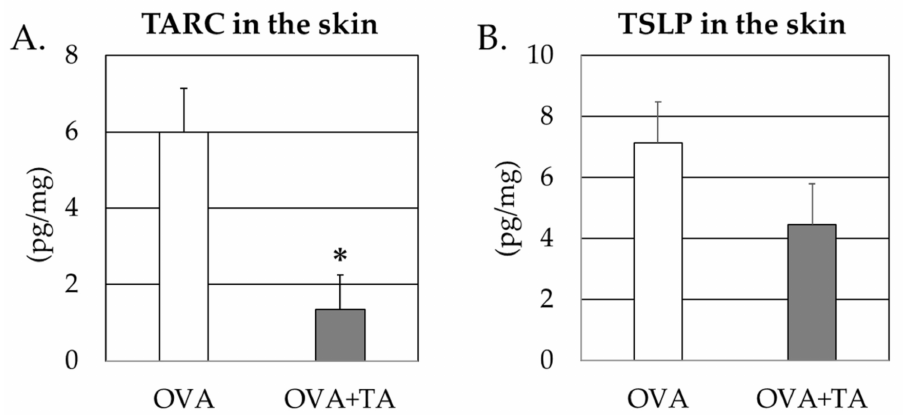
Figure 5. TSLP and TARC levels in the serum from the OVA and OVA + TA groups. ( A ) TARC levels in the serum at 3 w and 4 w. ( B ) TSLP levels in serum at 3 w and 4 w. Data are expressed as means ± standard deviations; OVA group ( n = 6), OVA + TA group ( n = 6). * p < 0.05.